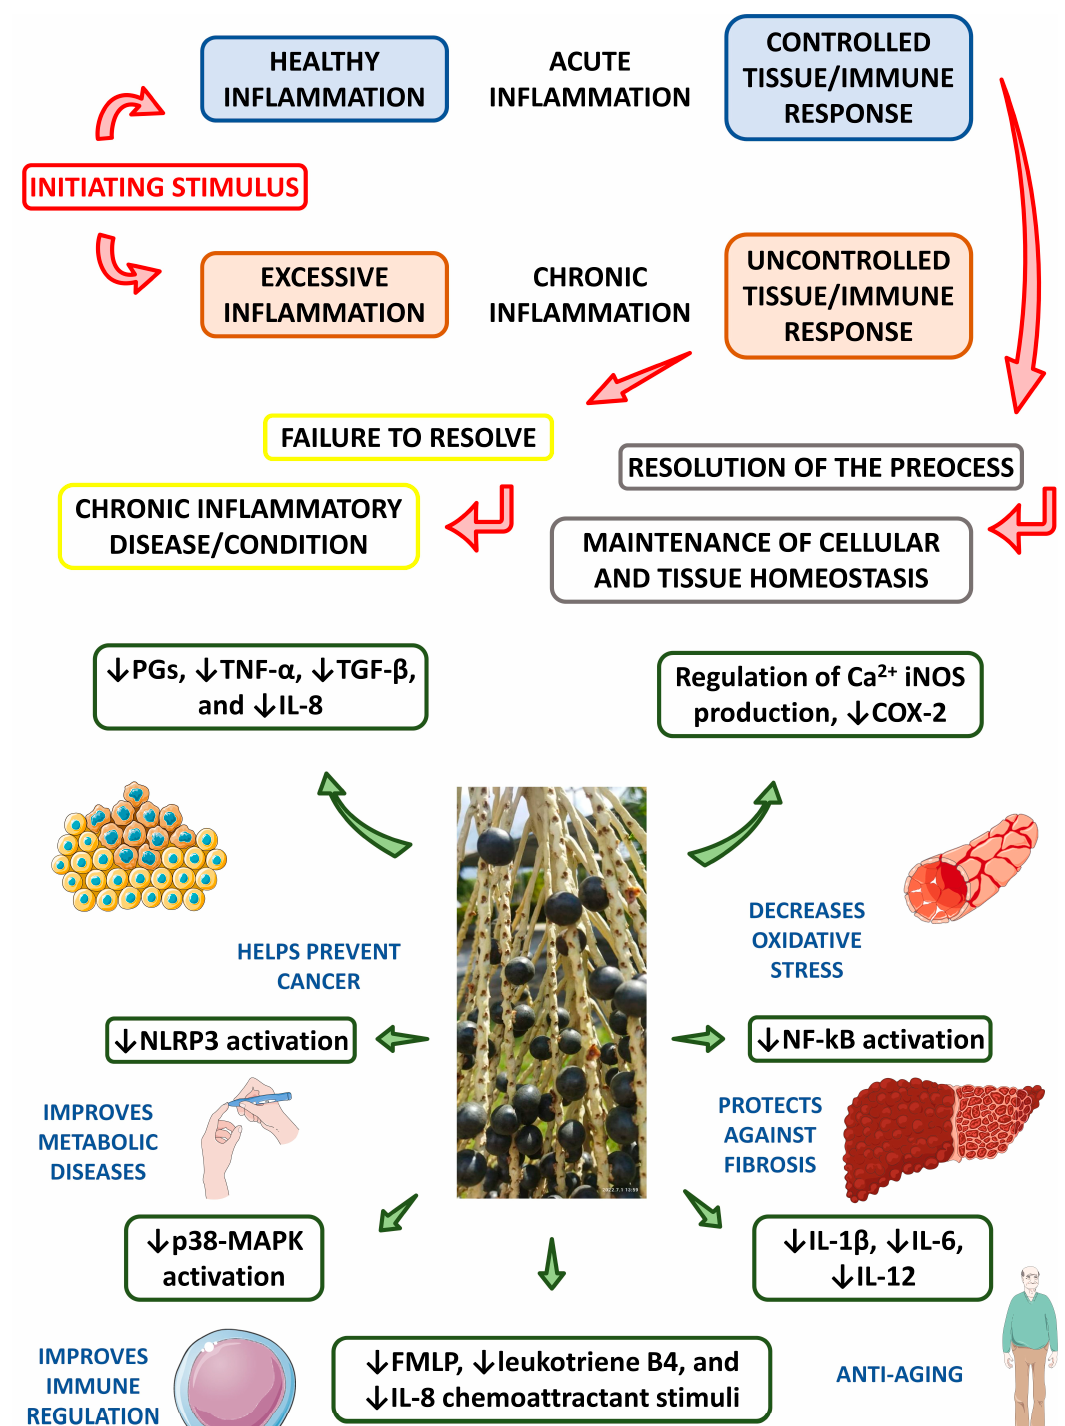
Figure 9. Anti ‐ inflammatory effects of açaí. Açaí improves anti ‐ inflammatory status by directly reducing the synthesis of proinflammatory cytokines and expression of proinflammatory signaling pathways. Symbols and abbreviations: ↑ : increase; ↓ : decrease; Ca 2+ : calcium; COX ‐ 2: cyclooxygenase ‐ 2; FMLP: N ‐ formylmethionyl ‐ leucyl ‐ phenylalanine; IL ‐ 1 β : interleukin ‐ 1 β ; IL ‐ 6: interleukin ‐ 6; IL ‐ 8: interleukin ‐ 8; IL ‐ 12: interleukin ‐ 12; NF ‐κ B: nuclear factor ‐κ B; iNOS: inflammatory nitric oxide synthase; PGs: prostaglandins; MAPK: mitogen ‐ activated protein kinase; TGF ‐β : transforming growth factor ‐β ; TNF ‐α : tumor necrosis factor ‐α .